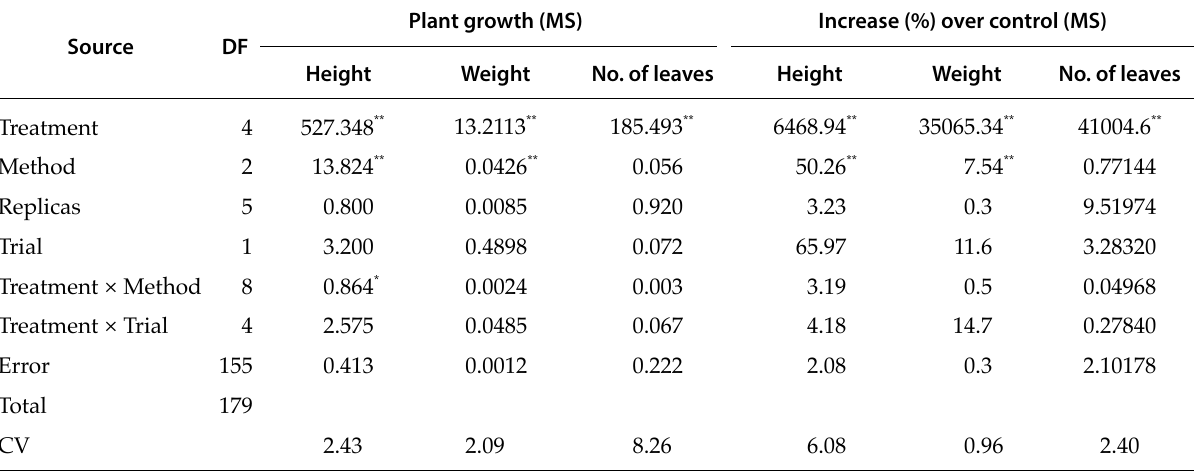
Table 3. Analyses of variance for plant growth parameters influenced by extract from four Chinese herbs under green - house